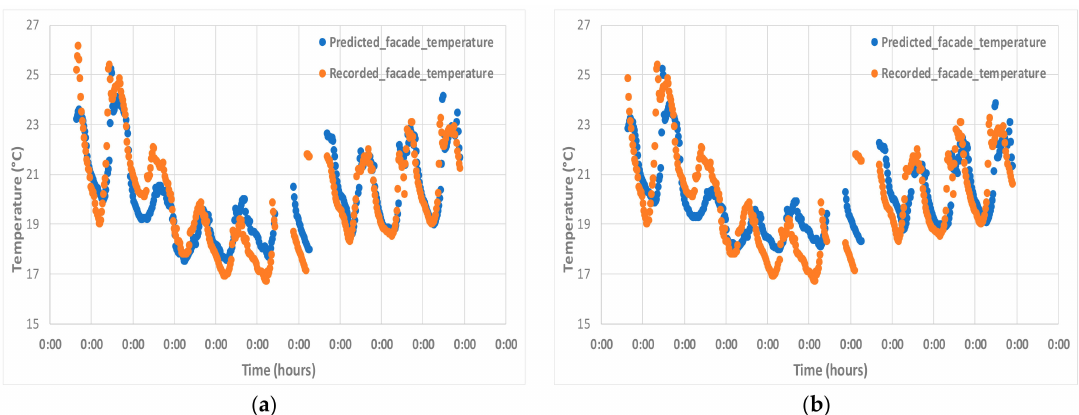
Figure 8. Recorded and predicted facade temperature variation in the time domain: ( a ) prediction for 2 h; ( b ) prediction for 4 h.